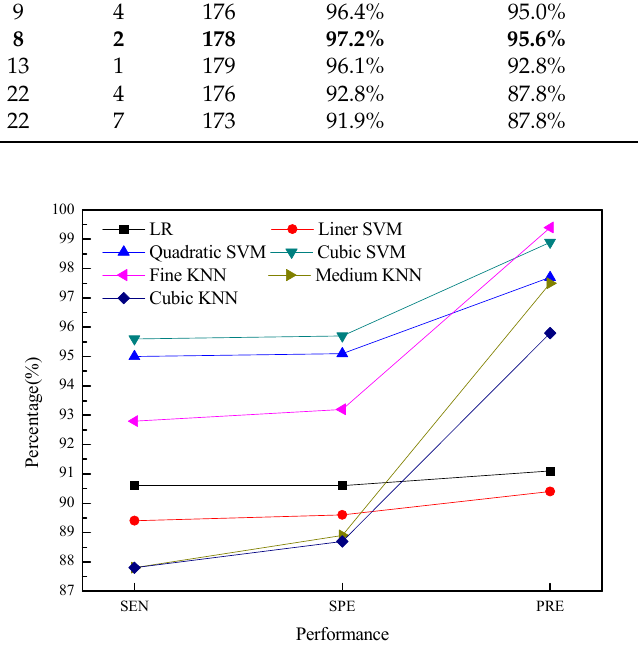
Figure 5. Performance plot of various classifiers.